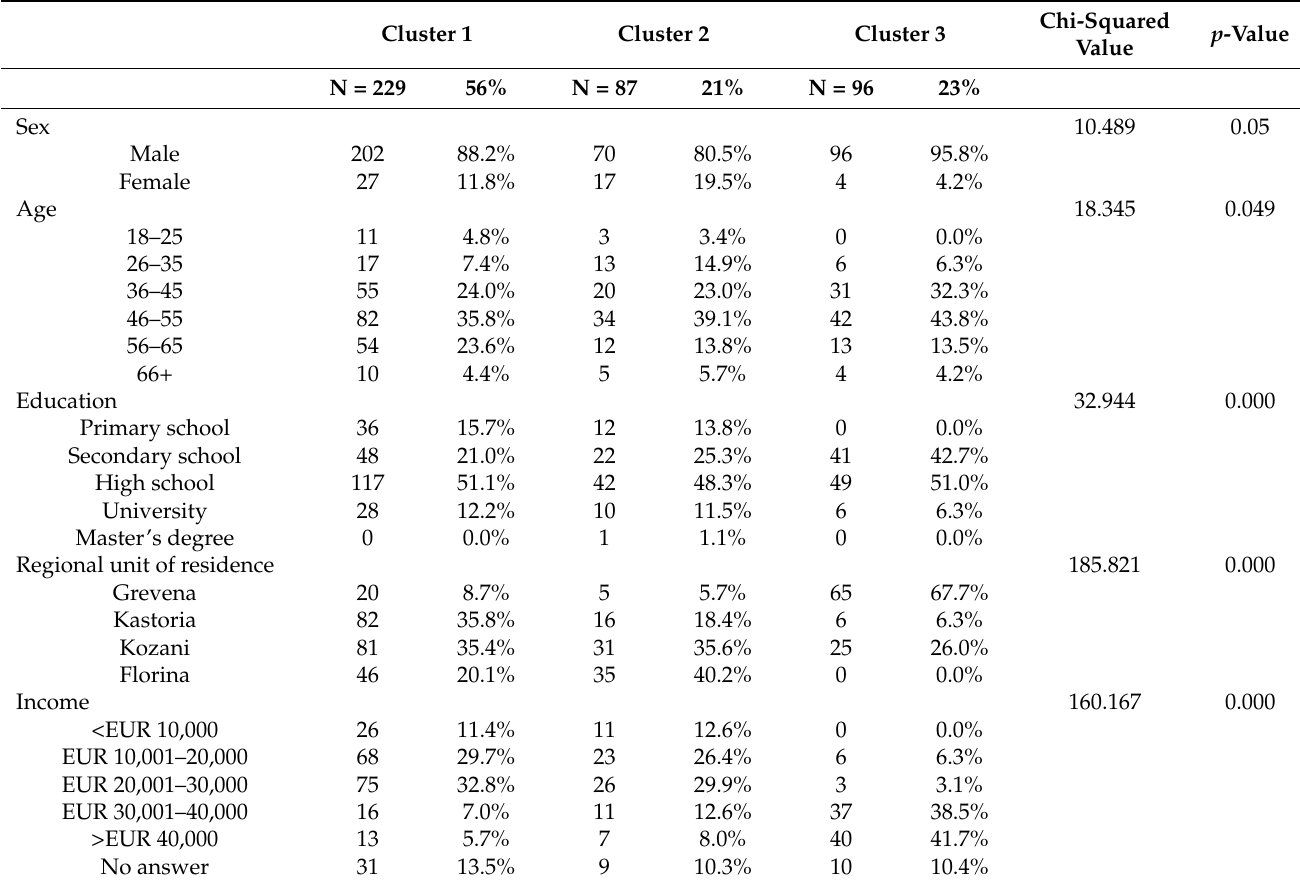
Table 7. Demographic profile of the three clusters of